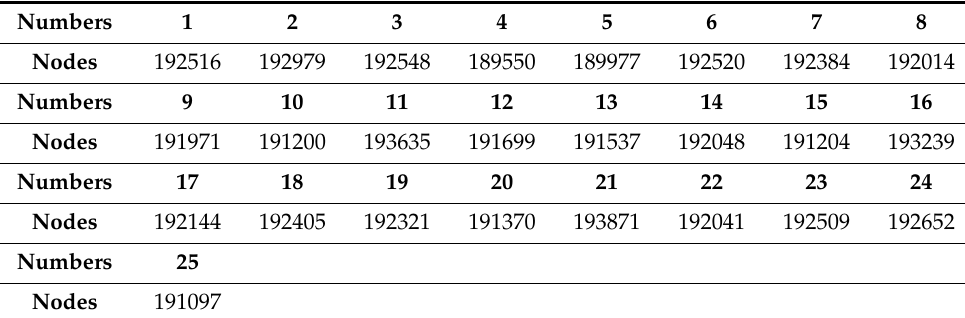
Table A2. Node information corresponding to Table 5 and Figures 14 and 15.